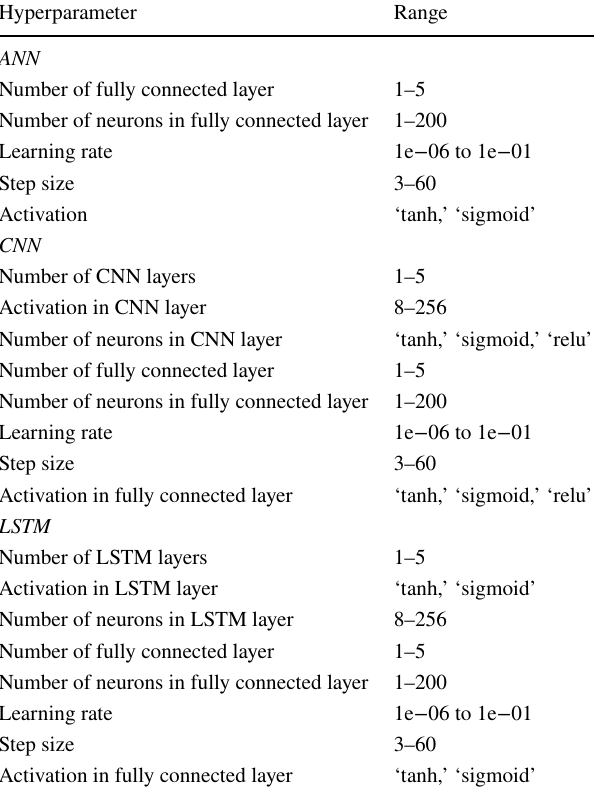
Table 1 Search space configuration for the hyperparameters